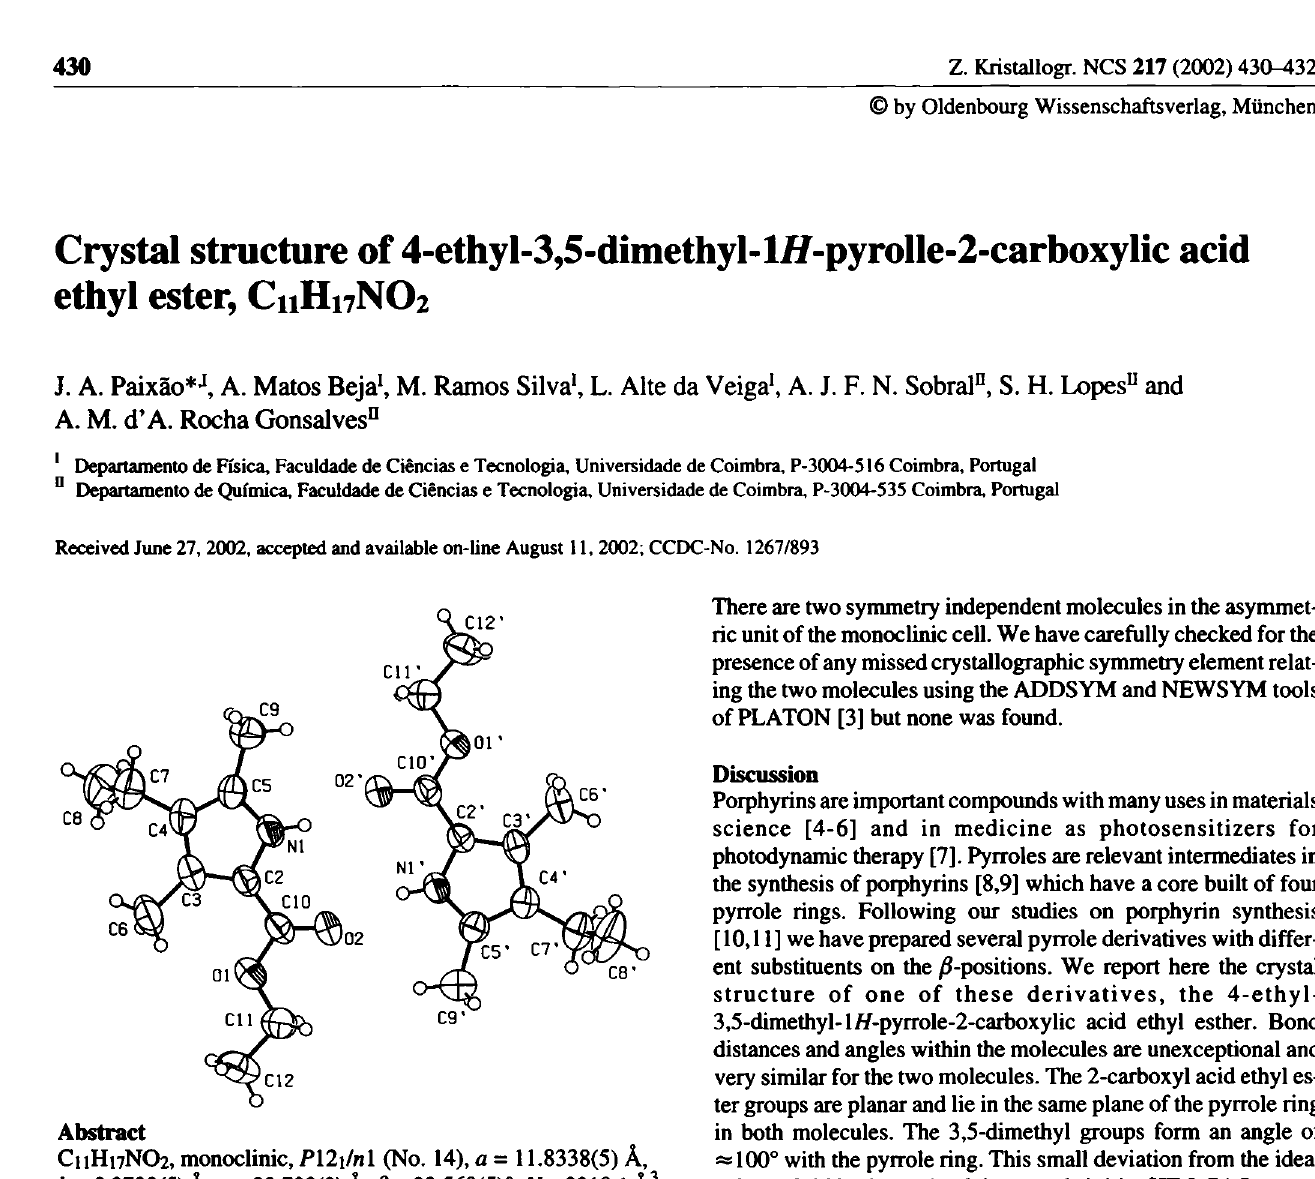
Table 1. Data collection and handling.